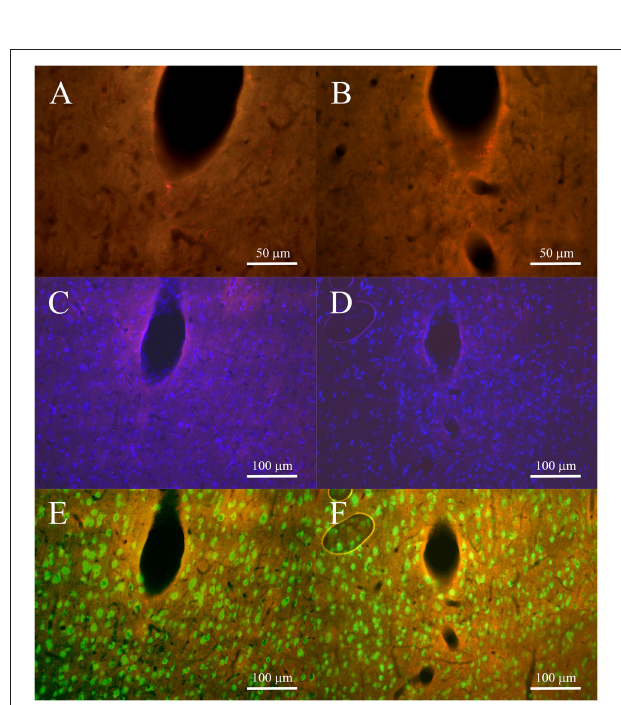
FIGURE 9 | Fluorescence microscopy images of tracks for non-encapsulated (left panels) and pHEMA-encapsulated (right panels) microspheres at 2 weeks after implant. (A,B) show the GFAP-positive cells (red) at 40 × to underline the morphology of astrocytes; (C,D) cell nuclei (blue) merged on GFAP staining to show the density of DAPI surrounding tracks; (E,F) neuronal nuclei (green) merged with GFAP staining to show the presence of neuronal bodies surrounding the track.